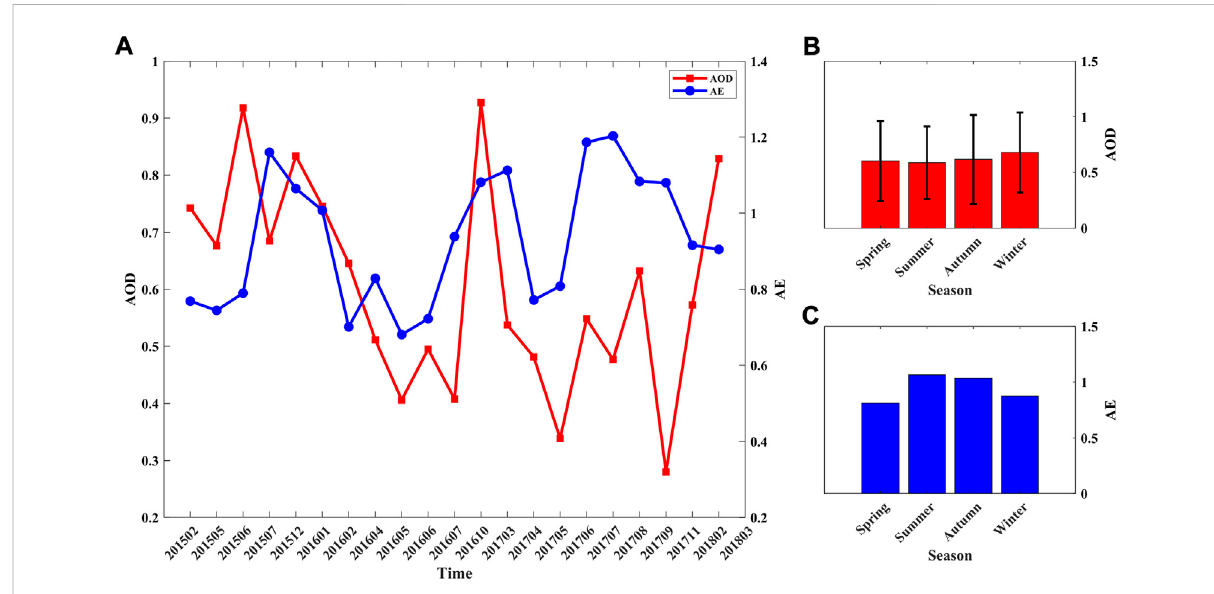
FIGURE 2 The monthly (A) and seasonal averages (B, C) AOD and AE during 2015 and 2018.